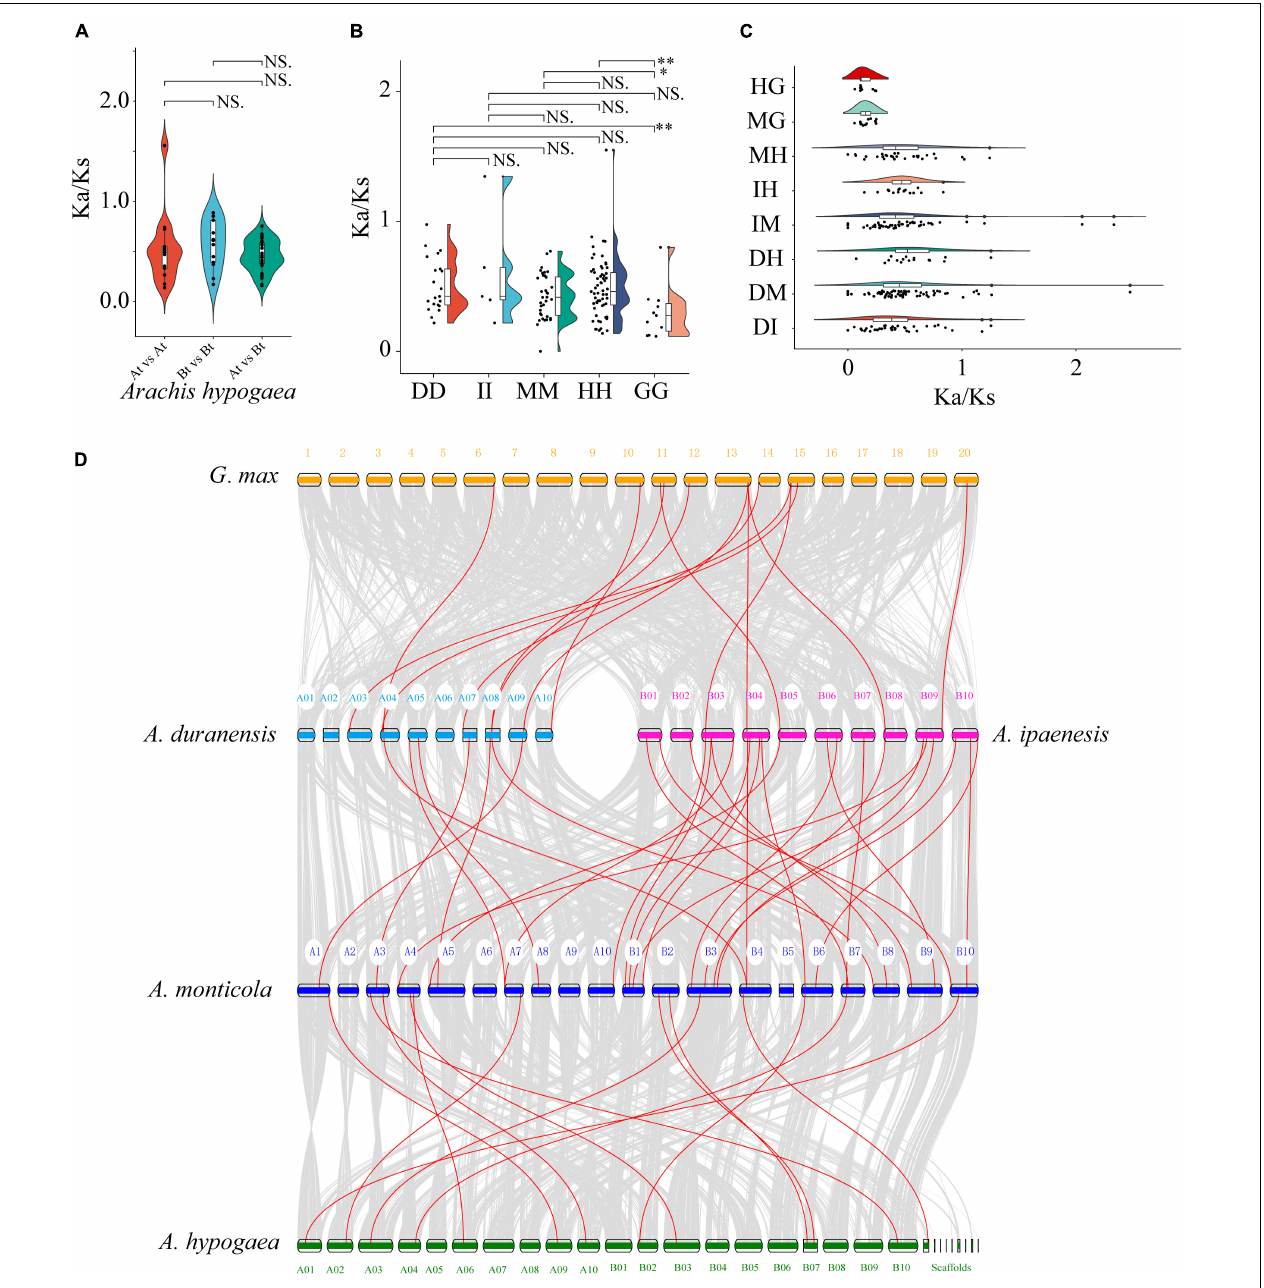
FIGURE 3 | The Ka/Ks and synteny analyzes of AhFAR1 genes among different plant species. (A) The comparison of Ka/Ks paralogous gene pairs within and between At and Bt. (B) The comparison of Ka/Ks paralogous gene pairs among Arachis and G. max . DD, A. duranensis ; II, A. ipaensis ; MM, A. monticola ; HH, A. hypogaea ; GG, G. max . (C) The comparison of Ka/Ks orthologous gene pairs among Arachis and G. max . HG, A. hypogaea vs. G. max ; MG, A. monticola vs. G. max ; MH, A. monticola vs. A. hypogaea ; IH, A. ipaensis vs. A. hypogaea ; IM, A. ipaensis vs. A. monticola ; DH, A. duranensis vs. A. hypogaea ; DM, A. duranensis vs. A. monticola ; DI, A. duranensis vs. A. ipaensis . (D) Synteny plot of AhFAR1 genes. Gray lines represent the collinear blocks between two plants, and red lines represent the syntenic AhFAR1 gene pairs. NS. represents no significant at 0.05 significance level. ∗ and ∗∗ indicate 0.05 and 0.01 significance level,